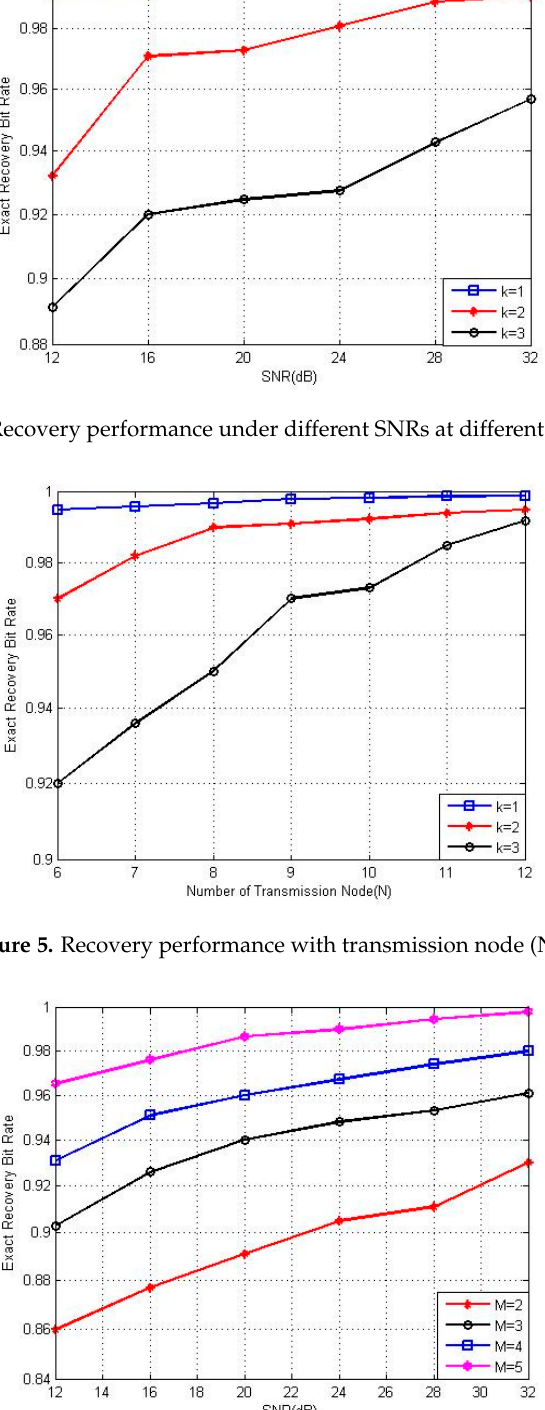
Figure 6. Recovery performance with receiving antennas M .